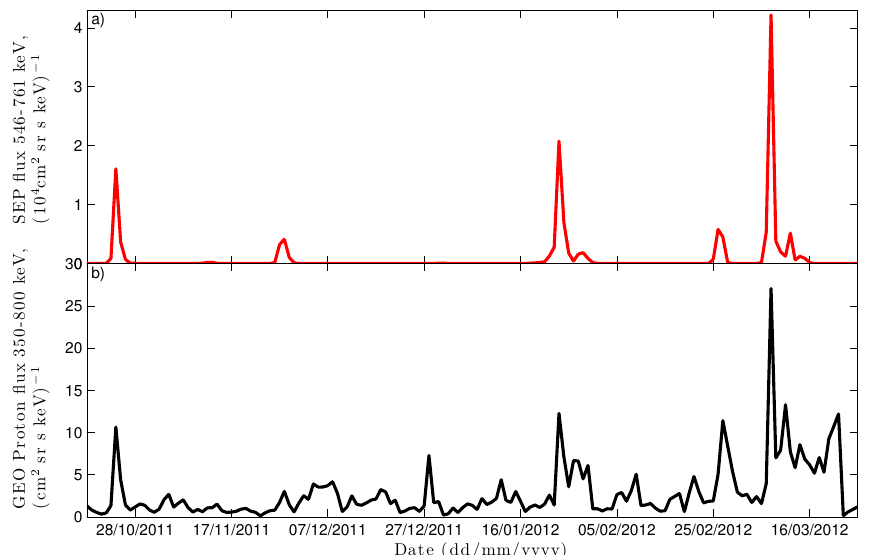
Fig. 2. Panel (a) displays the daily averaged SEP flux observed by the ACE EPAM for the energy range 546–761keV and panel (b) shows the daily averaged 350–800keV protons observed by GOES MAGPD, for the period between 18 October 2011 and 26 March 2012.